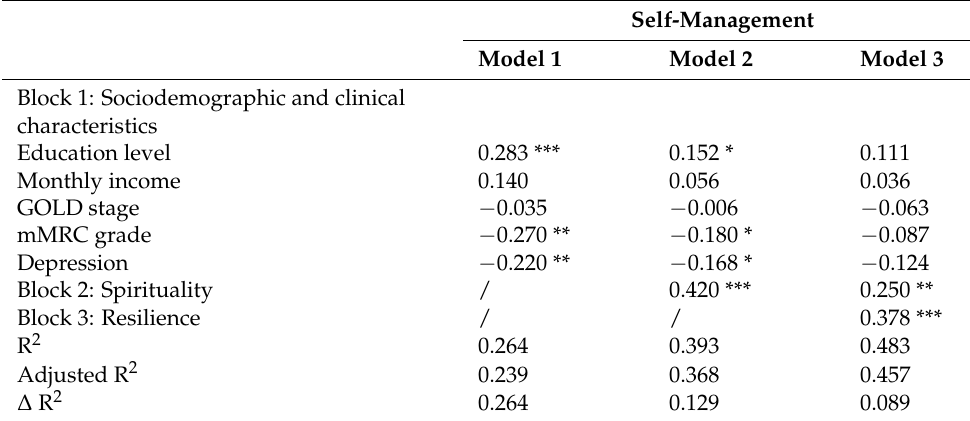
Table 4. The hierarchical multiple regression analyses of